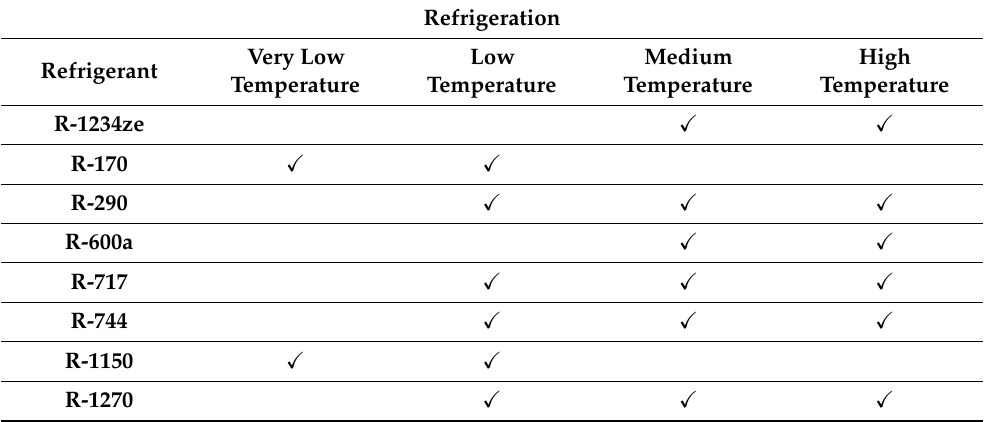
Table 3. Operating conditions for alternative and/or sustainable